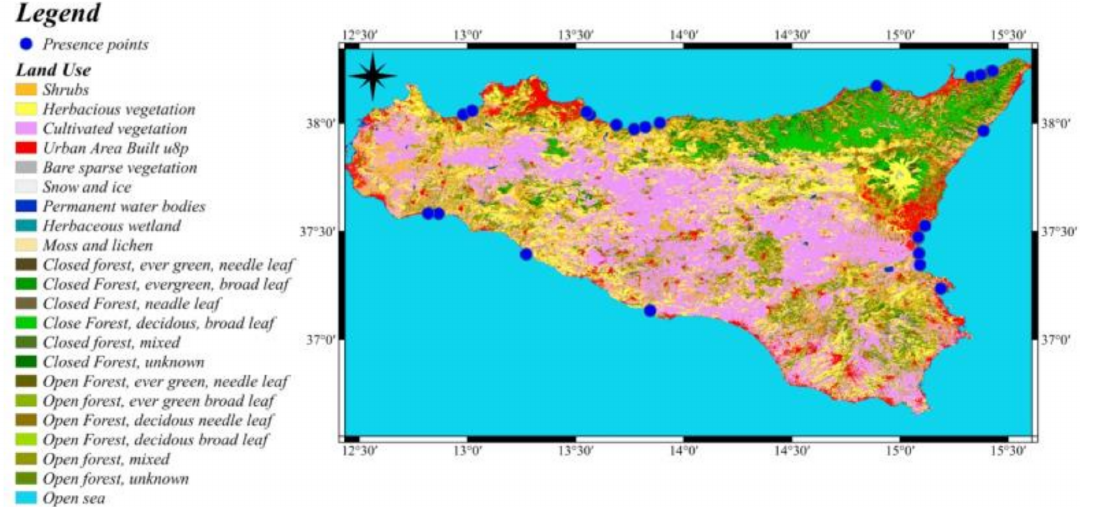
Figure A1. Distribution of Anoxia Orientalis Presence Points in Relation to Land Use in Sicily. The various CORINE landcover categories are given in the